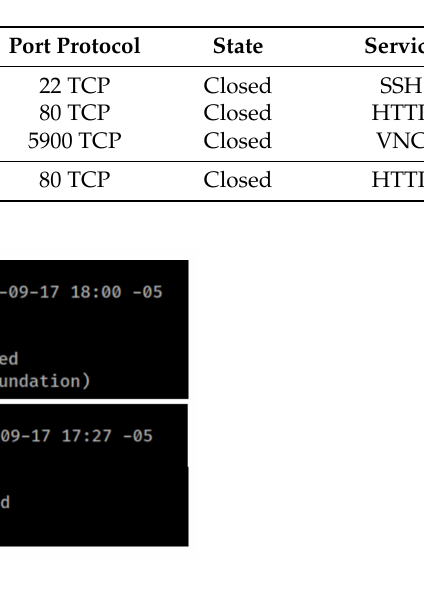
Table 22. Services found of IoT test scenario.